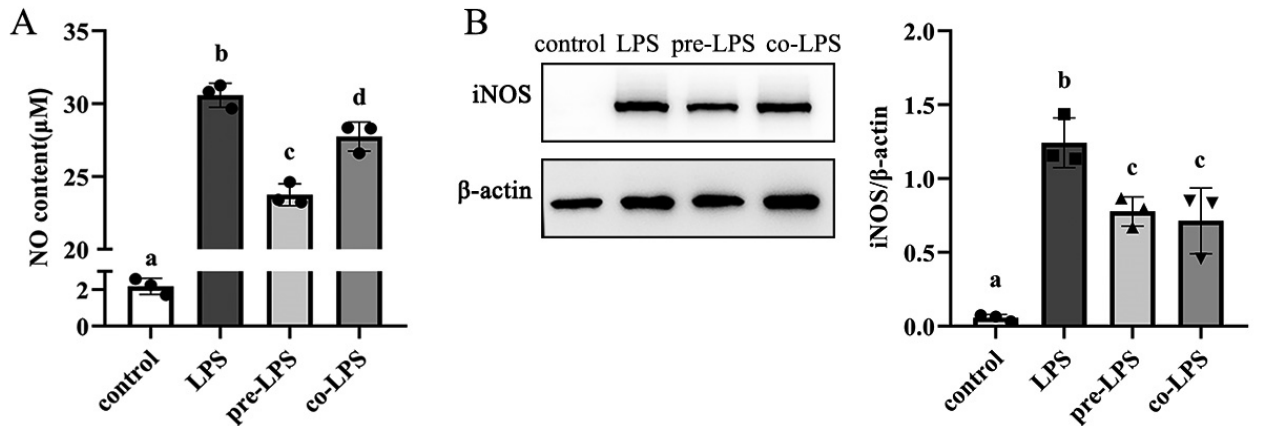
Figure 4. The effect of reuterin on the nitrite production of HD11 cells. The HD11 macrophages were respectively pretreated with 250 µ M retuterin for 12 h before LPS stimulation or cotreated with reuterin and LPS for 12 h. Control cells were cultured with normal medium without treatment. ( A ) Concentrations of nitric oxide in cellular supernatants from different groups. ( B ) The protein expression of iNOS of HD11 macrophages in different groups. Experimental results were presented as mean ± SD ( n = 3 replicates per group); different letters above column indicated the significant difference between groups ( p < 0.05).